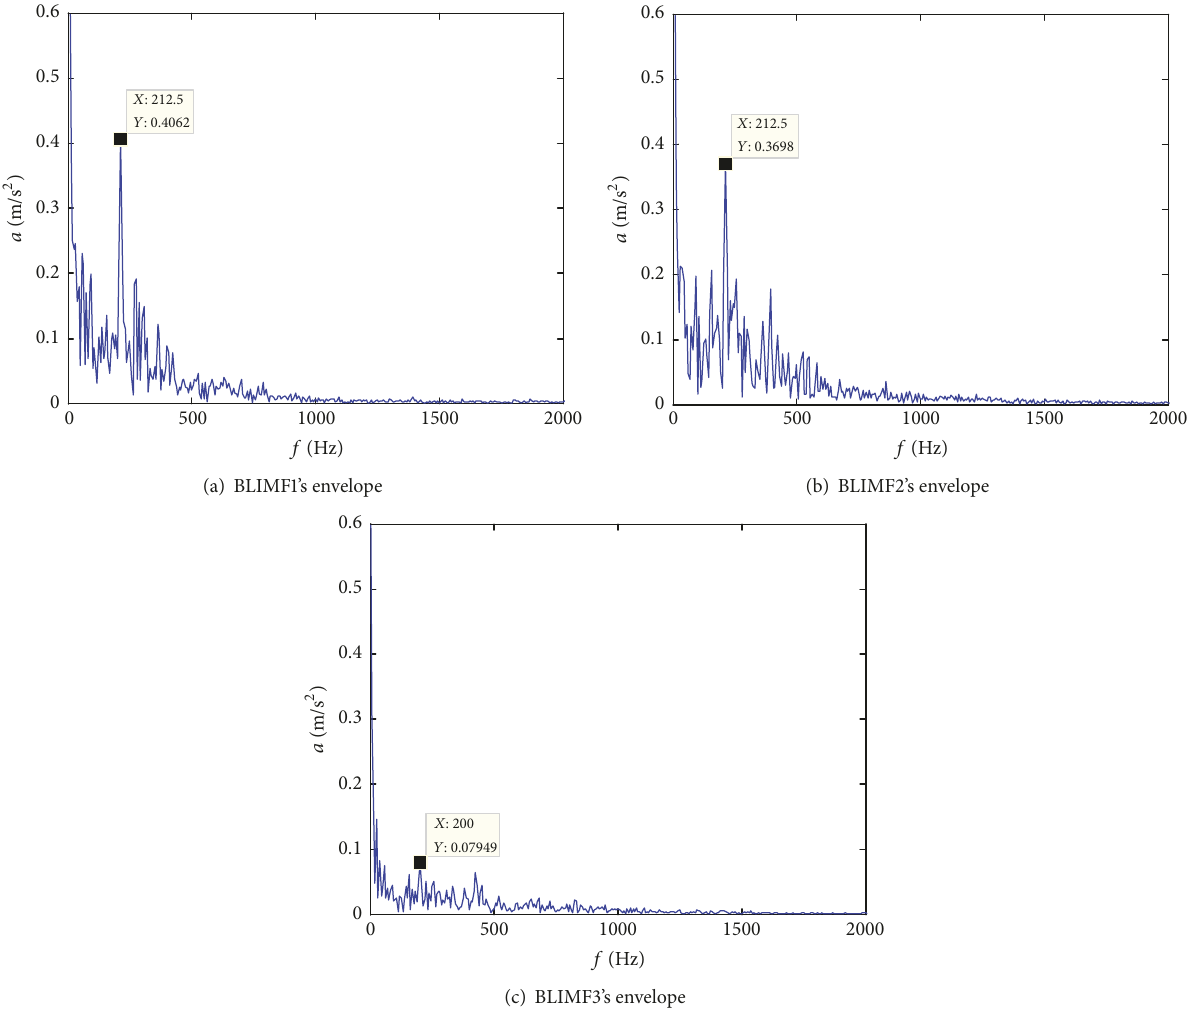
Figure 14: The envelope spectrum of BLIMF1 to BLIMF3 of #2600.